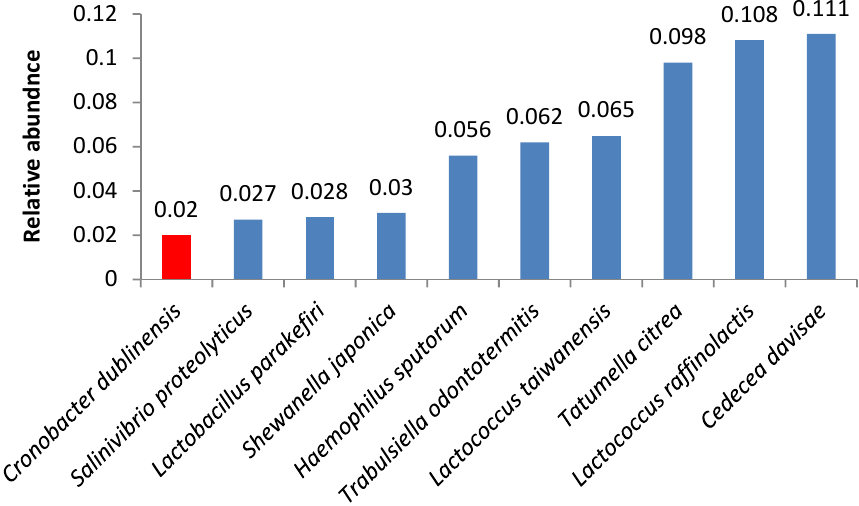
Figure 6. Relative abundance of amplicon sequence variants in butter sample no. 12.